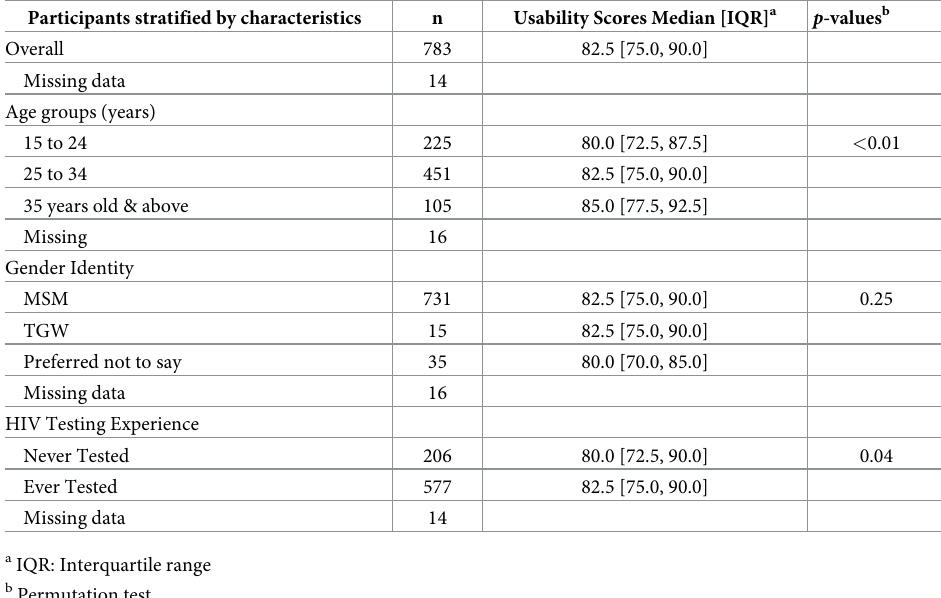
Table 4. HIVST kit SUS scores, stratified by non-reactive participants’ characteristics (N = 797). Participants stratified by